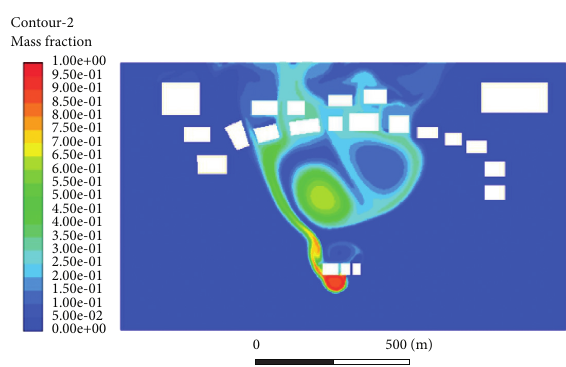
Figure 14: Radionuclide distribution rotating 90 ° clockwise at the western break.